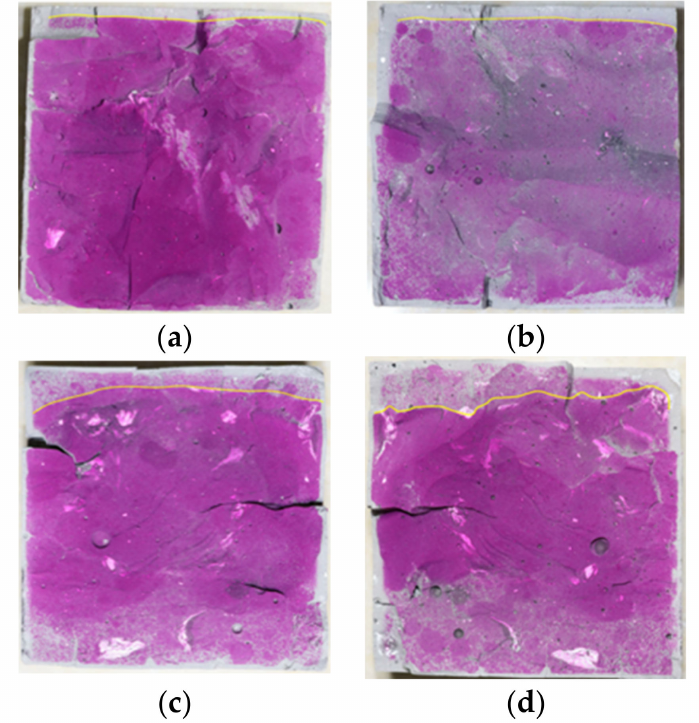
Figure 2. Phenolphthalein test diagram of carbonation depth in POK samples that had been subjected